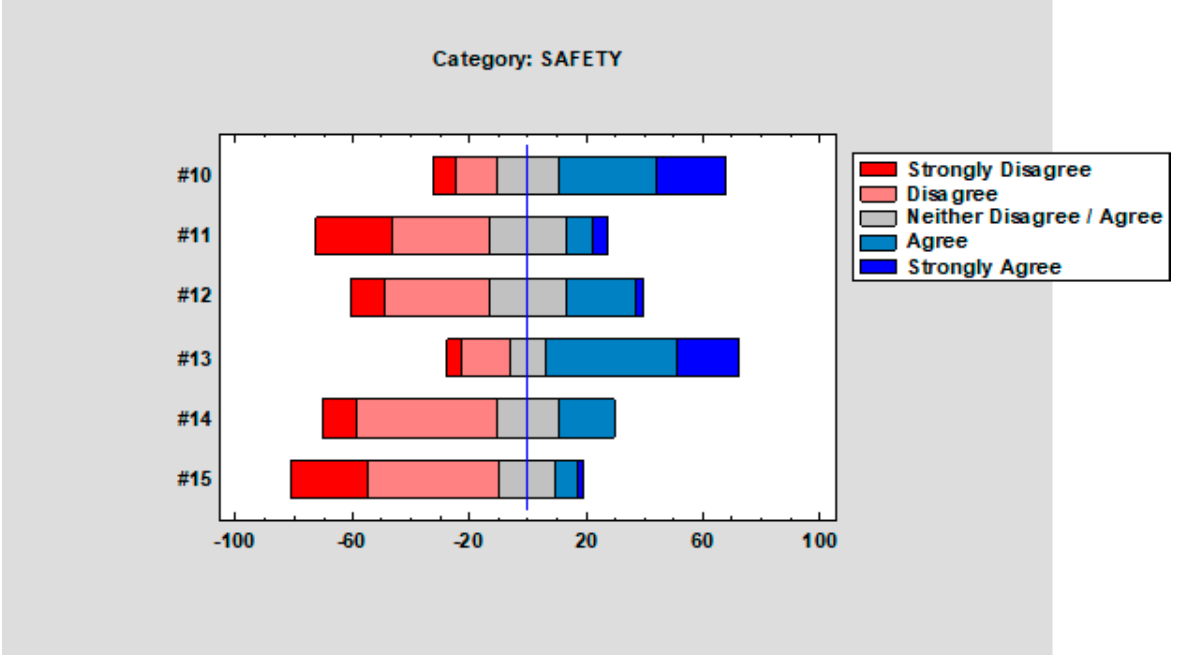
Figure 3. Likert Bar Graph representing scaled Safety Category question responses.